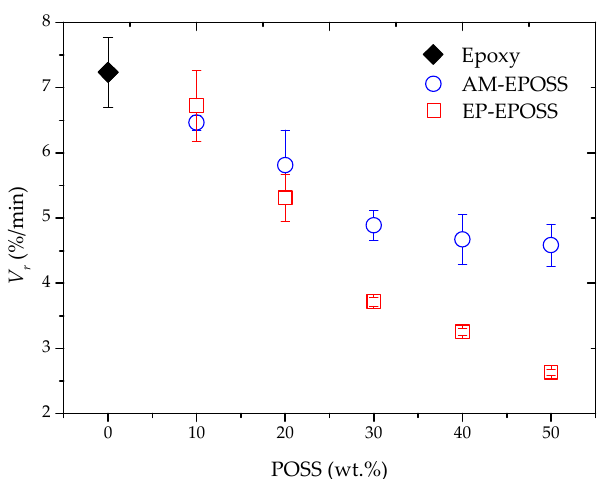
Figure Figure 10. The effect of POSS type and content on the recovery speed of EP–EPOSS and AM–EPOSS SMPs.